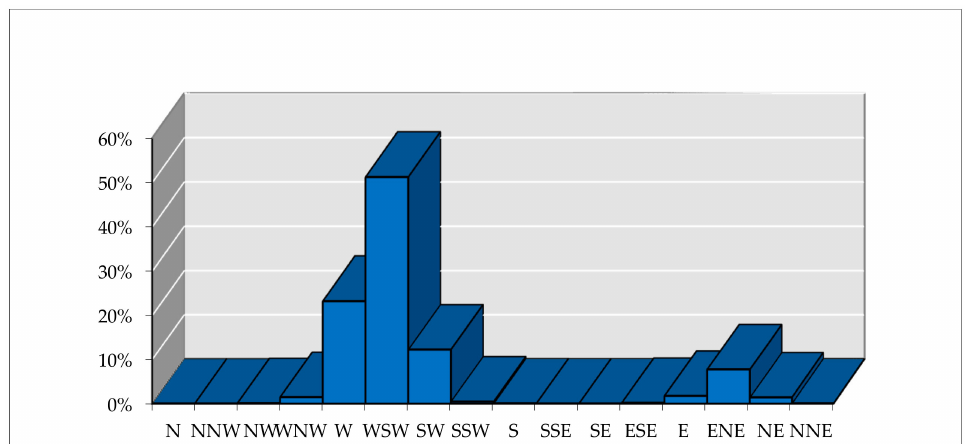
Figure 11. Energy distribution as a function of wind direction.